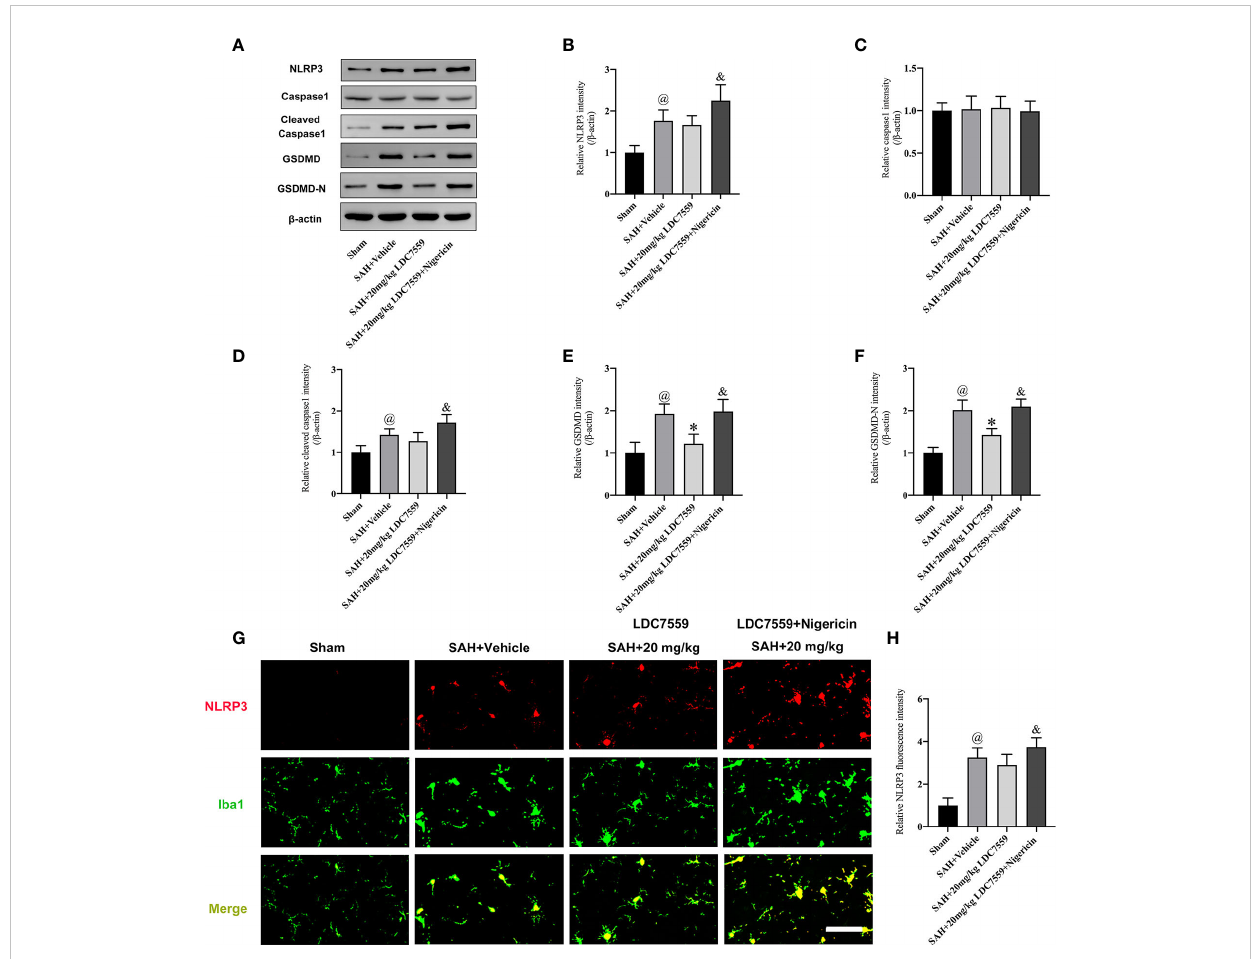
FIGURE 4 LDC7559 Treatment Inhibited GSDMD-mediated Signaling after SAH. Representative western blot bands (A) and quanti fi cation of the protein levels of NLRP3 (B) , caspase-1 (C) , cleaved caspase-1 (D) , GSDMD (E) , and cleaved GSDMD (F) (n = 6 per group). Representative immuno fl uorescence microphotographs of NLRP3 staining (G) in the ipsilateral hemisphere. Scale bar = 50 m m. Measurement of NLRP3 staining in the ipsilateral hemisphere (H) (n = 6 per group). Values are presented as the mean ± SD. @ P < 0.05 compared with sham group, * P < 0.05 compared with SAH + vehicle group, & P < 0.05 compared with SAH + 20mg/kg LDC7559